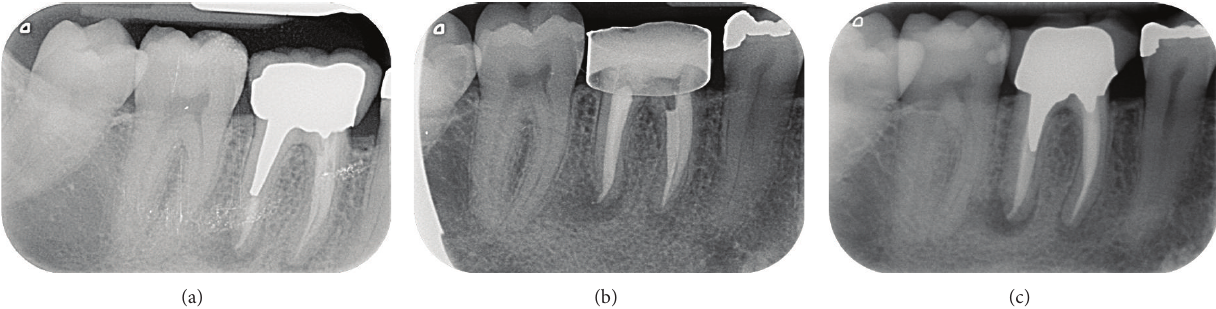
Figure 4: Case classified as failure. (a) Preoperative X-ray of the 46, painful, with an acute apical abcess. The previous endodontic treatment was performed 24 months ago. Note the apical radiolucency (PAI > 3 ). (b) Periapical X-ray control immediately after the retreatment. Note the copper ring used as preendodontic reconstitution. (c) Follow-up for 4 years: tooth was classified as “failure”: the apical radiolucency is always present and the tooth is symptomatic at the percussion test. The prosthodontics treatment and the coronal seal are questionable.